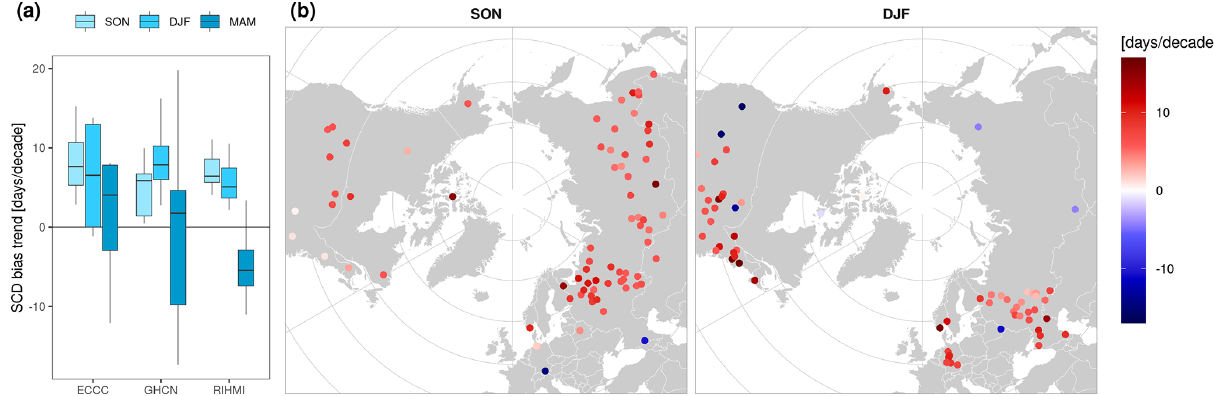
Figure 8. Decadal trend of the annual bias in seasonal snow cover duration (SCD) of the NOAA CDR from 1992 to 2015 (a) per network and (b) per station. Only significant trends ( p < 0 . 05, Mann–Kendall) are shown. The MAM map was excluded due to the lack of an artificial trend globally during that